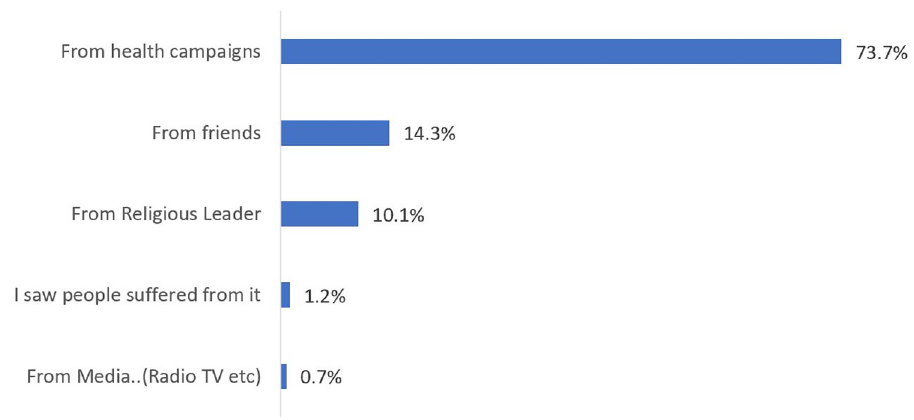
Fig 2. Main source of YF